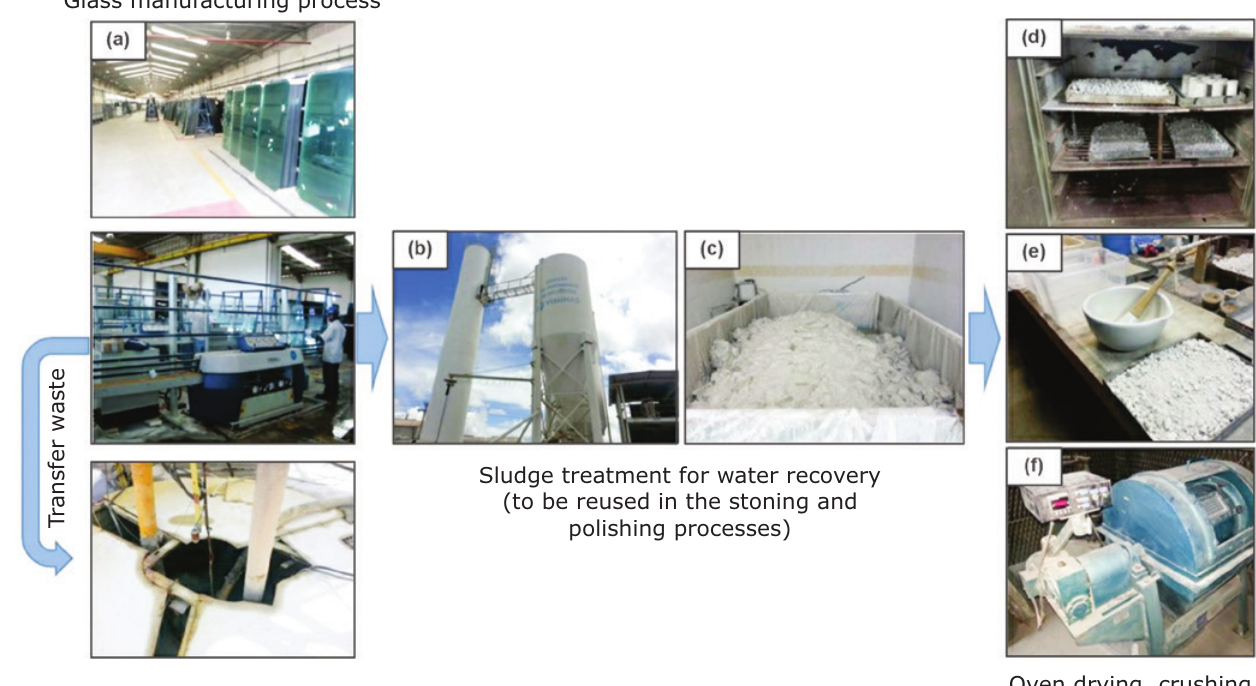
(a) Glass before stoning and polishing; (b) Silo for decantation; (c) Final waste after filter press; (d) Oven drying; (e) Crushing for breaking the lumps, GS1; (f) Ball mill for grinding, GS2